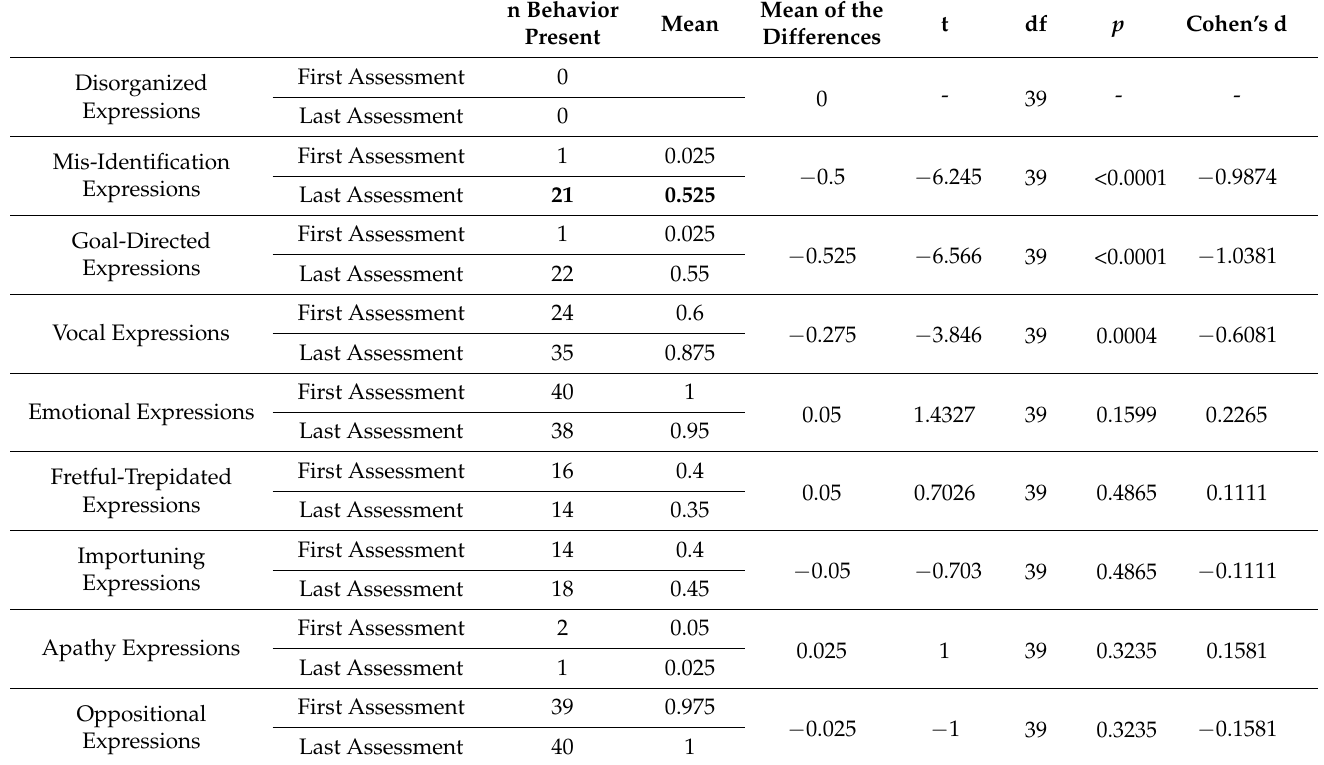
Table 7. Paired t-Test Confirmation of MANOVA with Cohen’s d